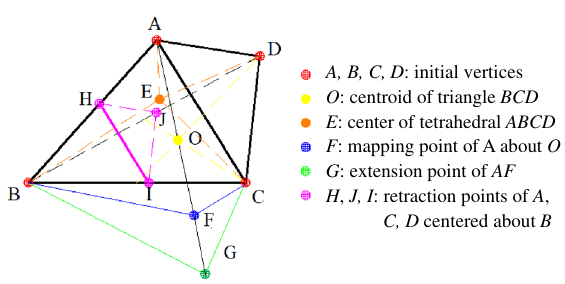
Figure 7. Schematic diagram of tetrahedral deformation based on simplex